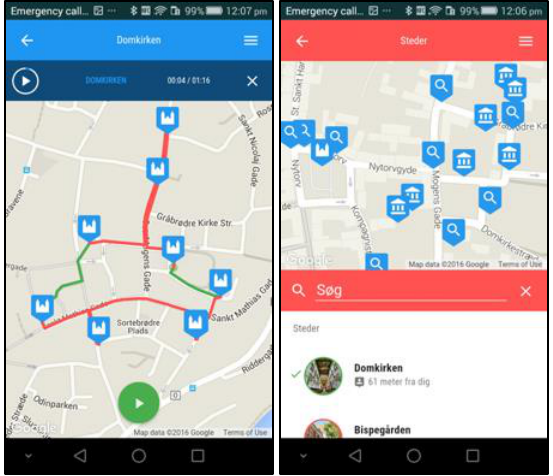
Figure 9. Screenshots of Spot Viborg app. Source: https://play.google.com/store/apps/details?id=dk.viborgkommu ne.SpotViborg&hl=it